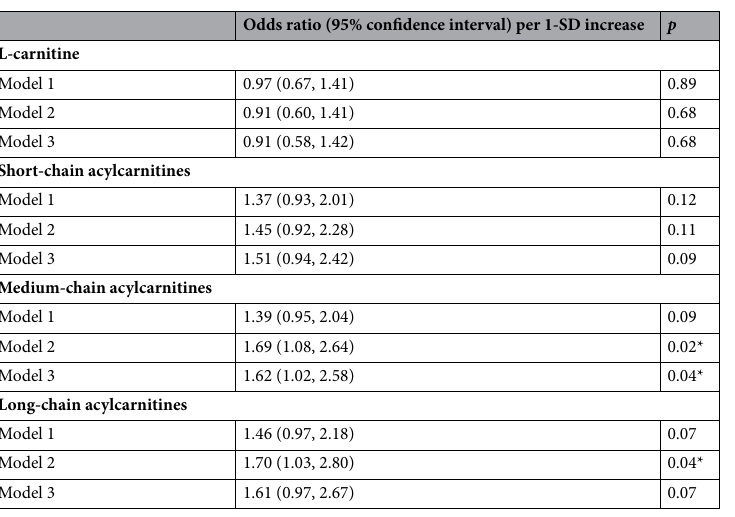
Table 3. Conditional logistic regression models for the association between L-carnitine and acylcarnitine scores, and 2-year incidence of lower-extremity functional impairment. Inverse normal transformation was applied to raw values of L-carnitine and acylcarnitines. Acylcarnitines were summed to calculate short-, medium-, and long-chain scores. Model 1 was a crude model, without adjusting for any covariate. Model 2 was adjusted for level of education (primary education or less, secondary school, university), BMI (< 25, 25–30, ≥ 30 kg/m 2 ), alcohol intake (tertiles), energy intake (tertiles), diabetes, cardiovascular disease, and osteomuscular disease. Model 3 was additionally adjusted for physical activity (tertiles). * p < 0.05.